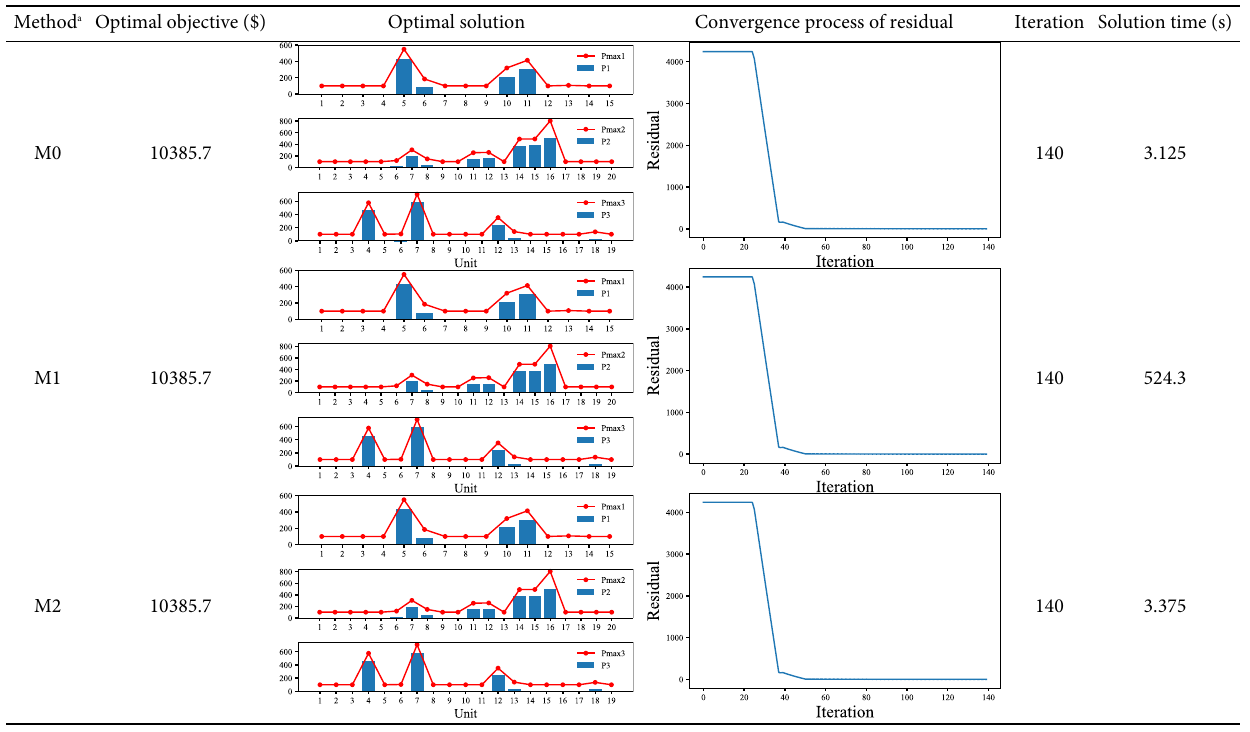
Table 3 Comparison of the scalability performance between the traditional LR method and SMPC-modified LR